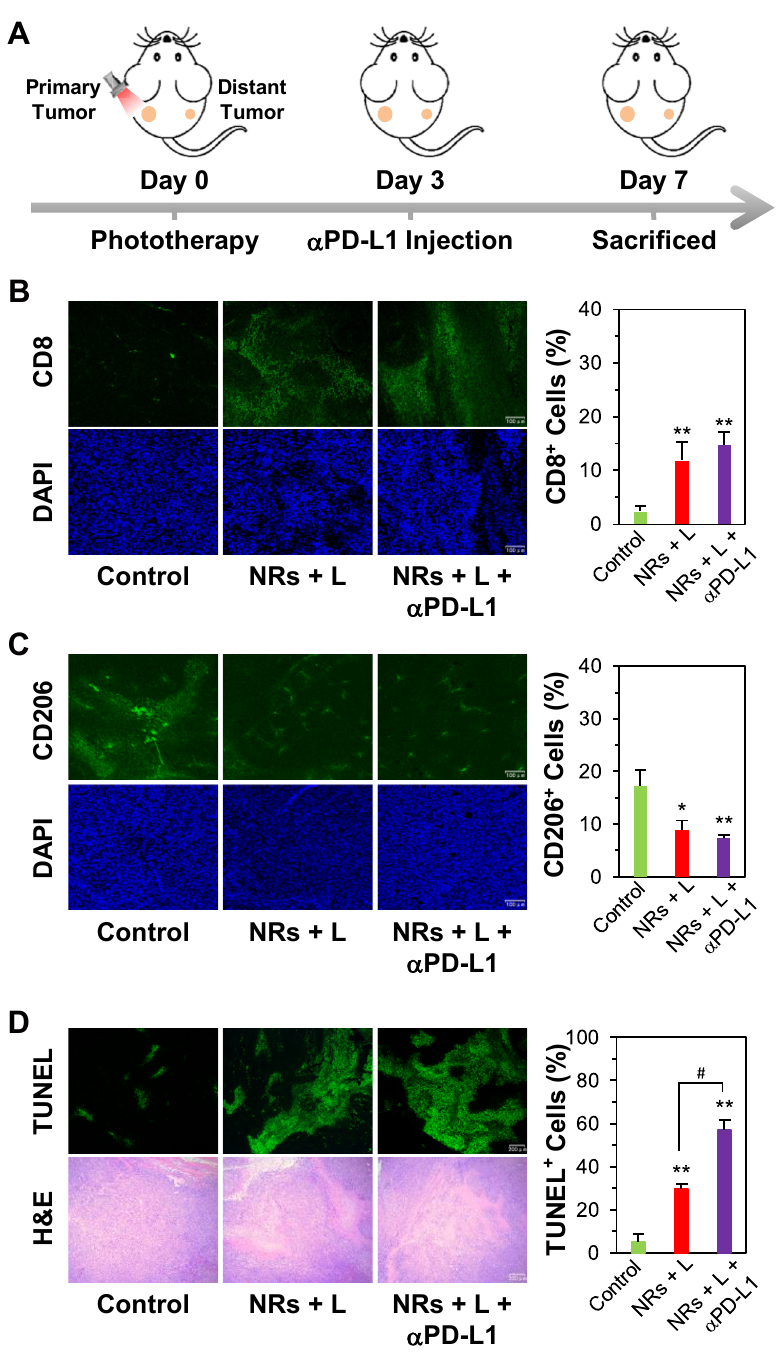
Figure 4: Abscopal effect of Fe2P-PEG-Mal NRs based